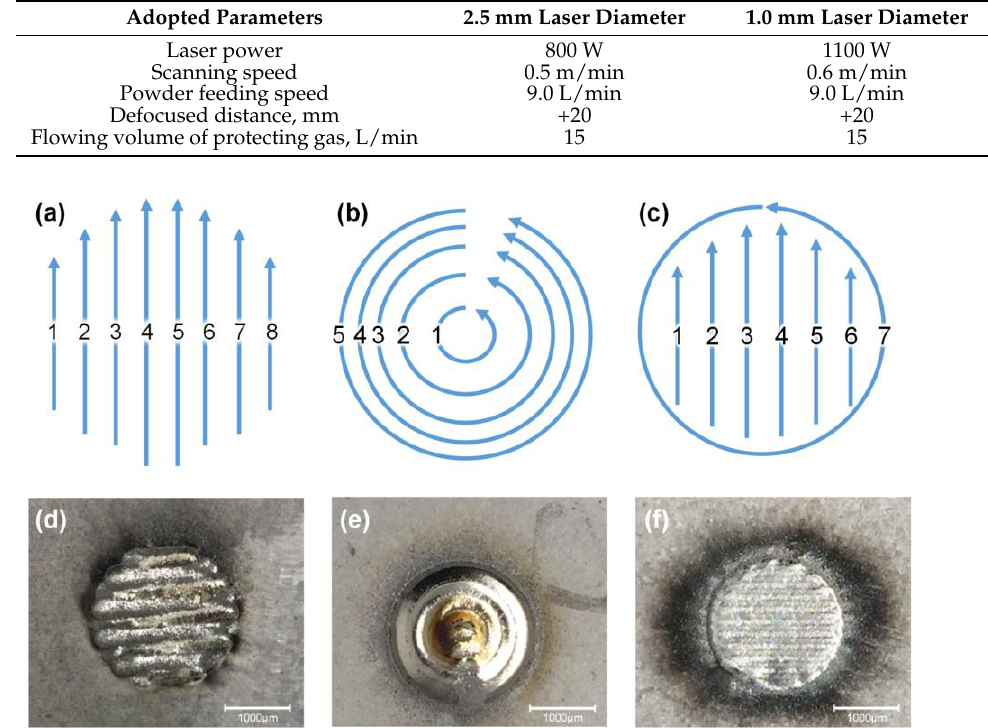
Figure 4. Repairing formation under different repairing paths: ( a , d ) Sequential, ( b , e ) Annular, ( c , f ) Sequential + outer annular. ( c , f ) Sequential + outer annular.